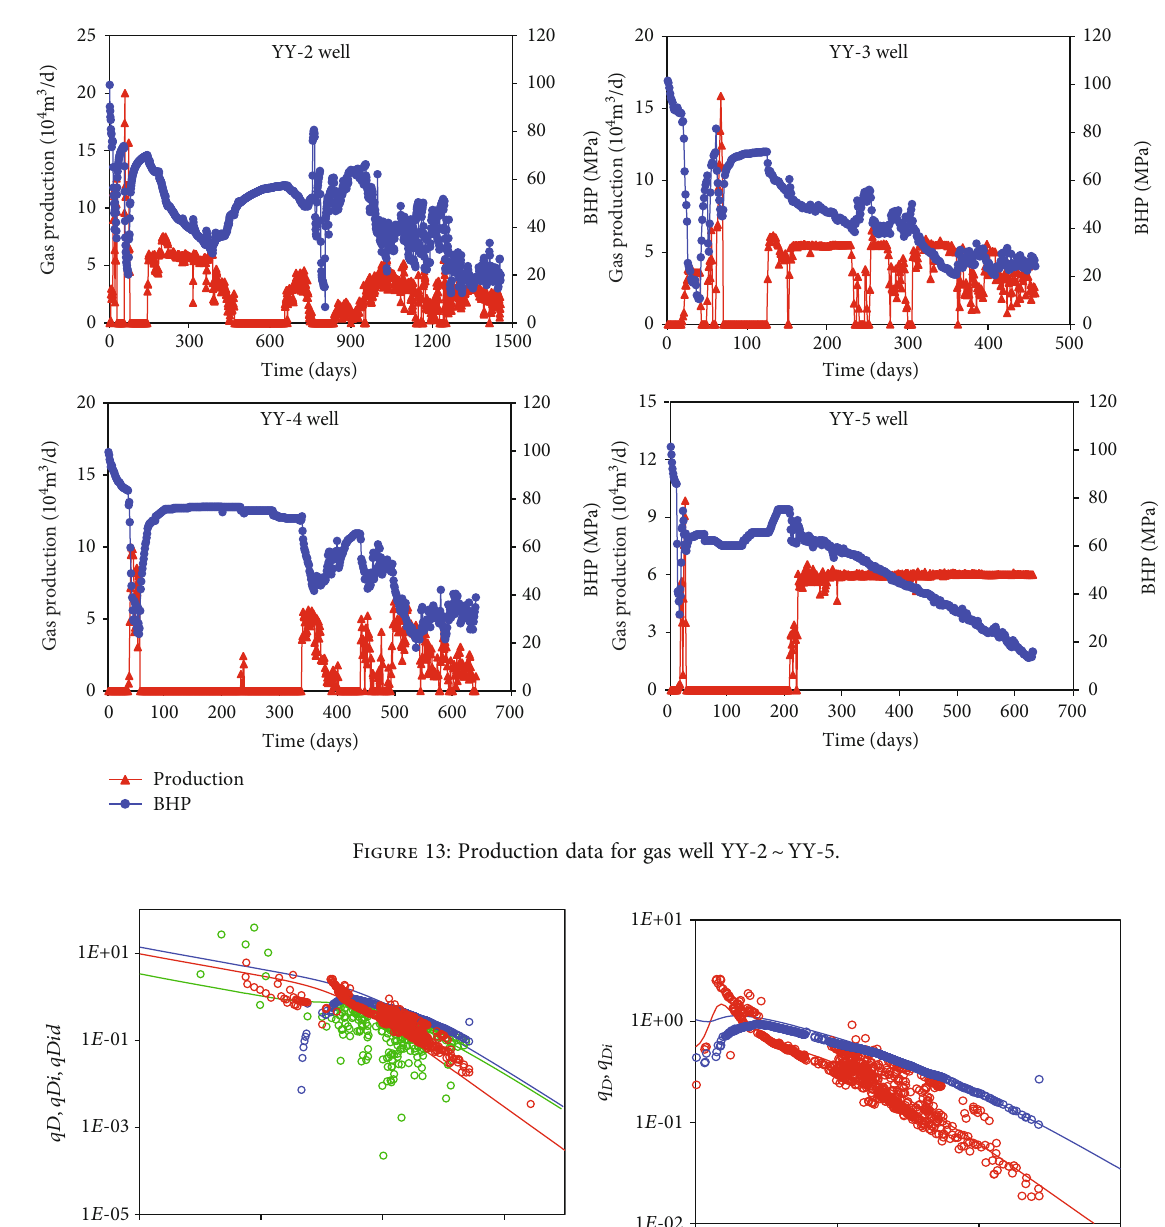
Figure 14: Type curve fi tting of YY-2 production data considering (a) and ignoring (b) the uneven support of